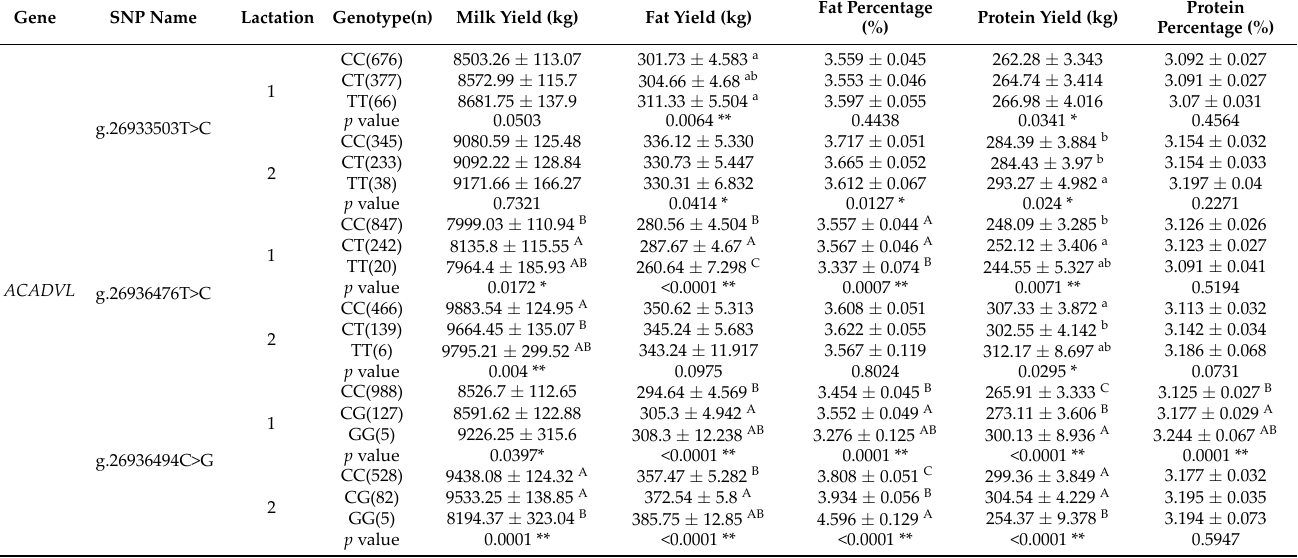
Table 2. Associations of the SNPs in the ACADVL and IRF6 genes with milk production traits in two lactations in Holstein cattle (LSM ±